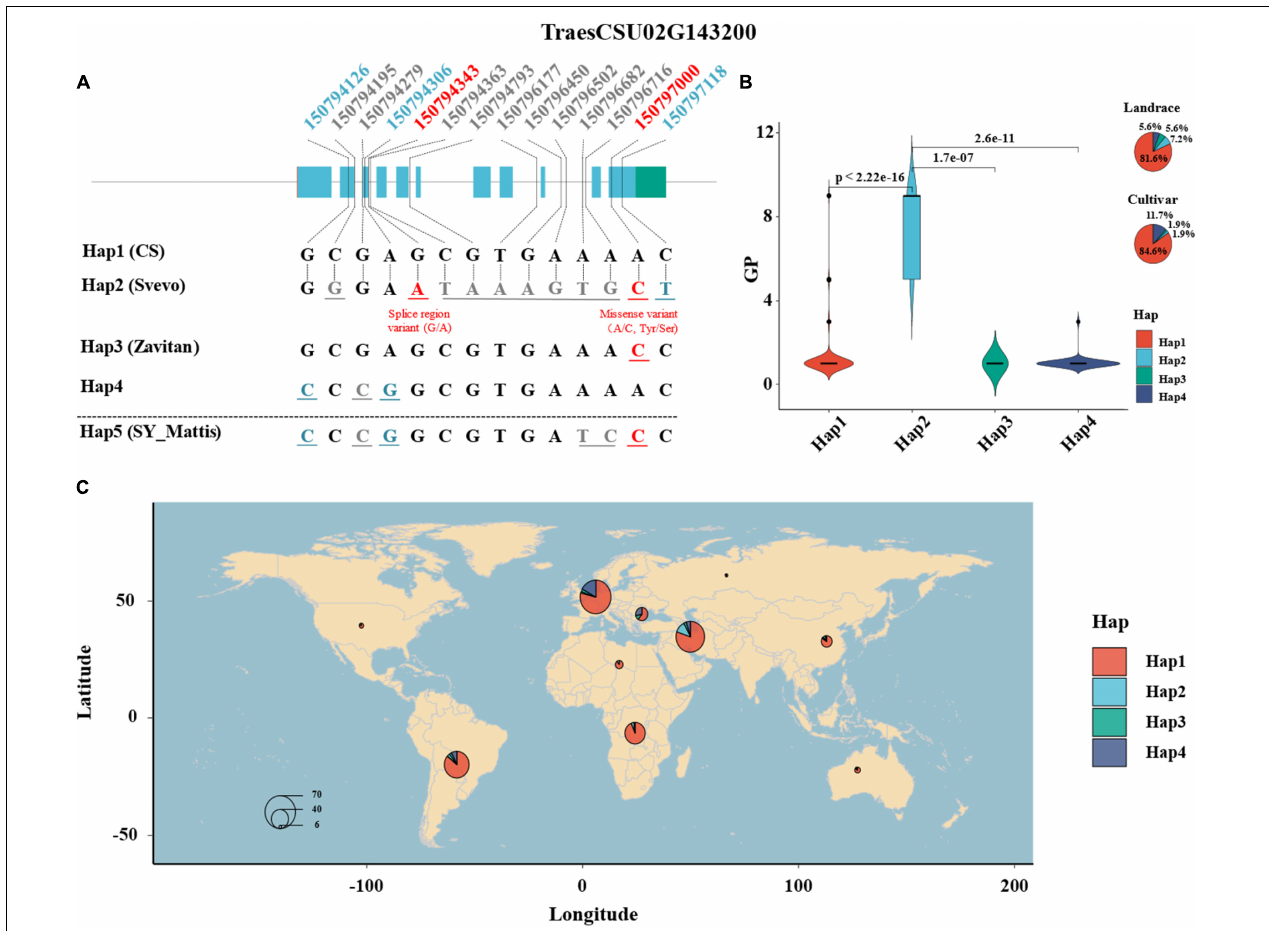
FIGURE 4 | Haplotype analysis of TraesCSU02G143200 in 352 wheat accessions and the pan-genomes. (A) The haplotype and sequence analysis of TraesCSU02G143200 among 352 wheat accessions, involving 10+ hexaploid wheat and the tetraploid wheat Zavitan and Svevo reference genomes. The numbers at the top indicate the genomic positions of the SNPs on TraesCSU02G143200 among the population; the numbers and the corresponding base letters with gray color indicate that the SNP variants are in the introns of TraesCSU02G143200 ; the numbers and corresponding base letters with blue or red color indicate that the SNP variants are in the exons of TraesCSU02G143200 , blue means the SNPs with synonymous mutations, red means the two SNPs with function mutations on TraesCSU02G143200 , a splice region variant (G/A) at Un:150794343 and a missense variant (A/C, Tyr/Ser) at Un:150797000. (B) The haplotypes of TraesCSU02G143200 and theirs Gp score comparison and frequency distribution among 352 wheat accessions. (C) The geographical distribution and frequency of the haplotypes of TraesCSU02G143200 . The size of the pie is proportional to the sample